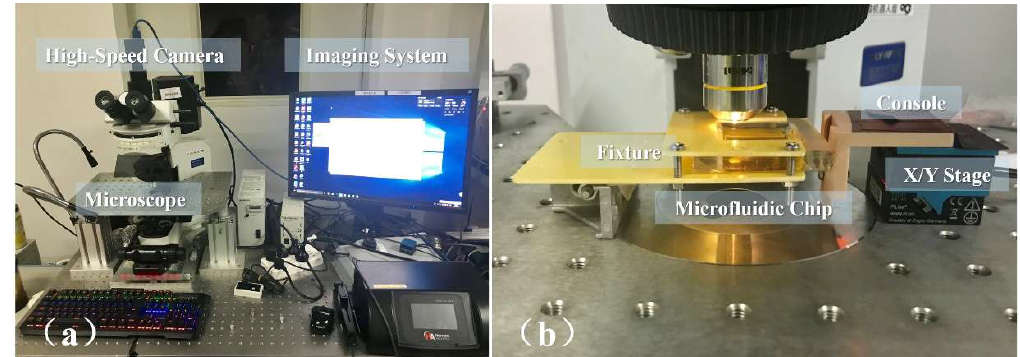
Figure 8. Photograph of experimental setup: ( a ) Observation system, ( b ) control system.